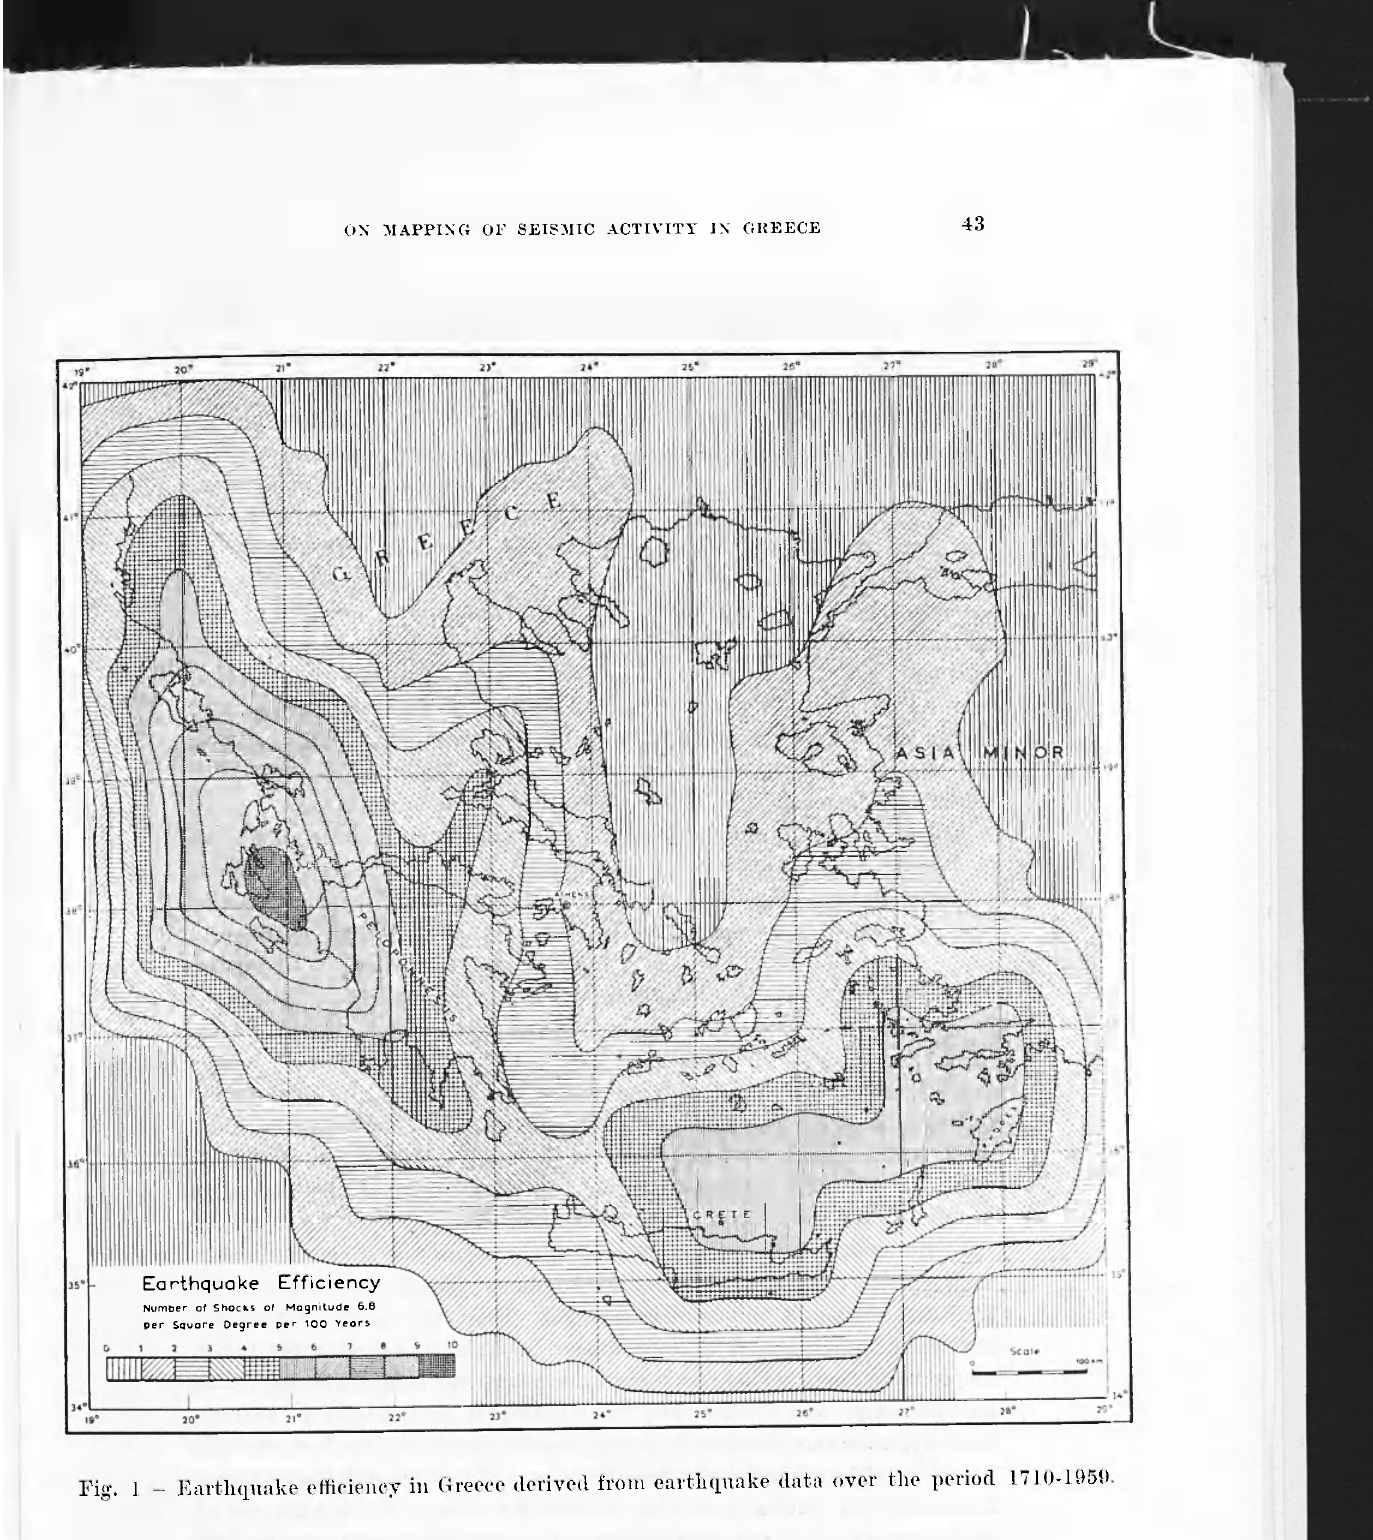
Fig. 1 - Earthquake efficiency in Greece derived from earthquake data over tlie period